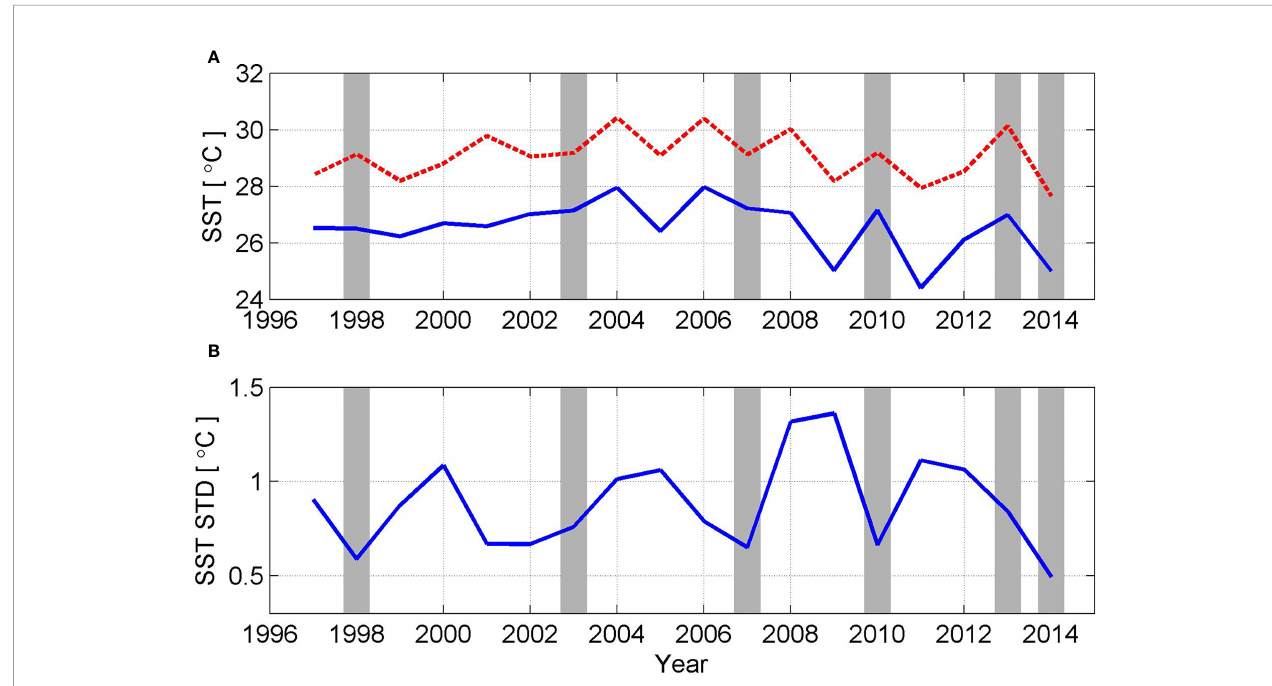
FIGURE 11 | (A) Mean and maximum of SST for the hypoxia area (122° – 124°E, 31° – 33°N) from 1997 to 2014, with units of °C. Gray shaded areas indicate hypoxia events. (B) Same as (A) , but for the standard deviation of